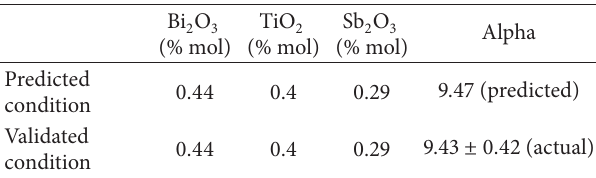
Table 4: The model experimental predicted and validated values of alpha at the prediction conditions.